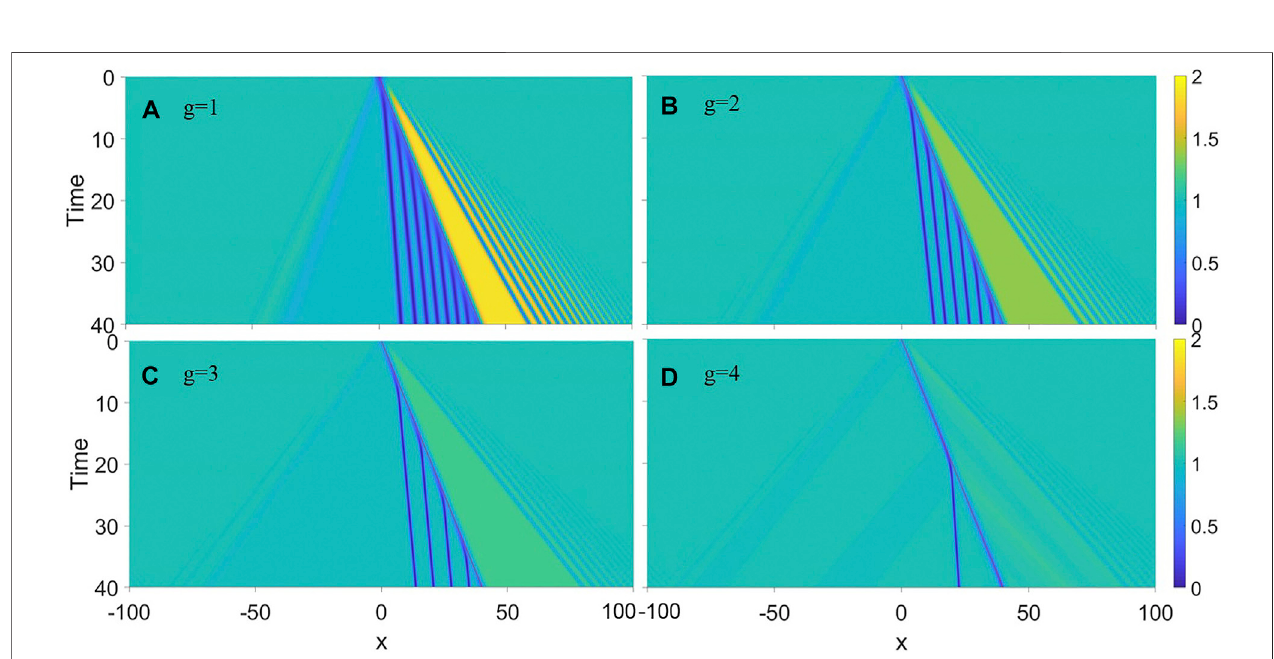
FIGURE 2 | Comparison of soliton emission from a moving obstacle in a condensate of different nonlinear strength, (A) g (cid:2) 1, (B) g (cid:2) 2, (C) g (cid:2) 3, (D) g (cid:2) 4, respectively. The Gaussian obstacle with potential height A (cid:2) 1 moves at fi xed velocity v (cid:2) 1.